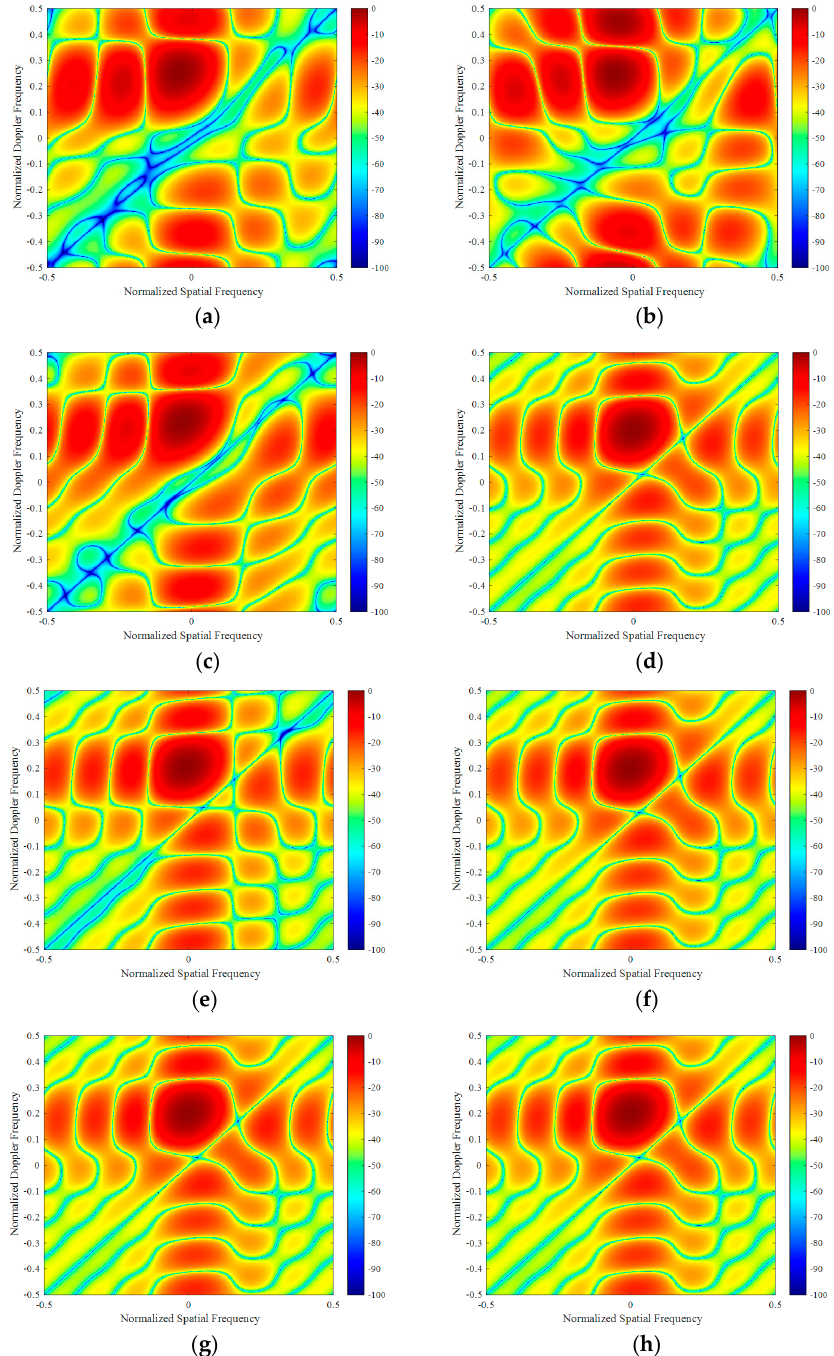
Figure 5. Spatial-temporal responses. ( a ) M-CVX; ( b ) M-OMP; ( c ) M-FOCUSS; ( d ) M-IAA; ( e ) M-SBL; ( f ) M-FCSBL; ( g ) M-SBL-IR (cid:96) 2,1 ; ( h ) Proposed algorithm.